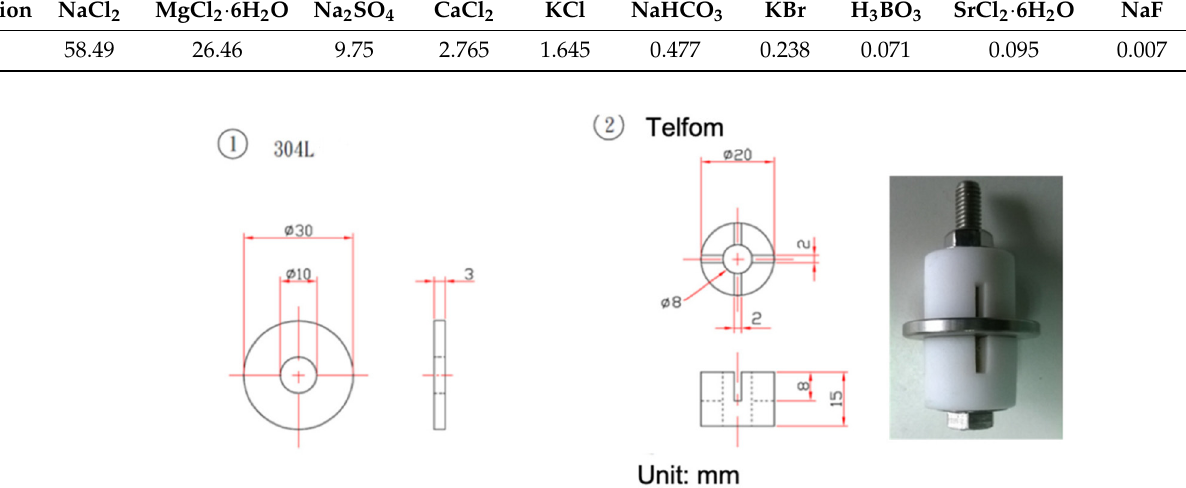
Figure 1. The dimensions of: (1) the SS 304L specimen and (2) crevice former device.